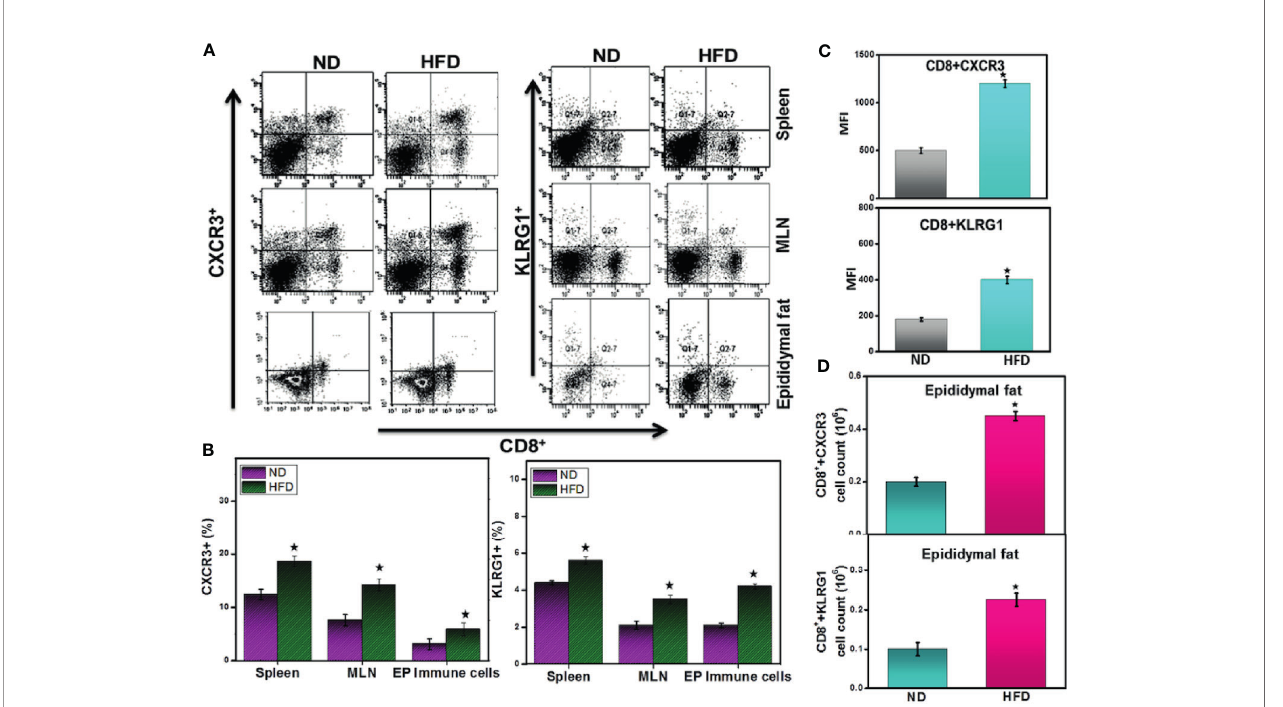
FIGURE 6 | DIO induces the expression of CXCR3 and KLRG1 by CD8 + T cells in adipose tissue. In a diet-induced obesity model, HFD mediates CXCR3- and KLRG1-expressing CD8 + T cells in mice 16 weeks after induction. Splenic, MLNs and epididymal adipocytes were isolated from the two groups of mice. Changes in the frequency of CD8 + CXCR3 + T cells ( A left panel and B ), CD8 + KLRG1 + T cells ( A right panel and B ), changes in CXCR3 + and KLRG1 + mean fl uorescence intensity (MFI) (C) , and absolute numbers of CXCR3 + and KLRG1 + in the AT (D) were determined by fl ow cytometry and expressed as the mean percentage of cells/mice ± SEM. The cumulative data shown are from a total n =18, representative experiment; three independent experiments involving six mice per group yielded similar results. *p < 0.05, unpaired student ’ s t-test indicates statistically signi fi cant differences in MFI and numbers of CXCR3 and KLRG1 between ND and HFD